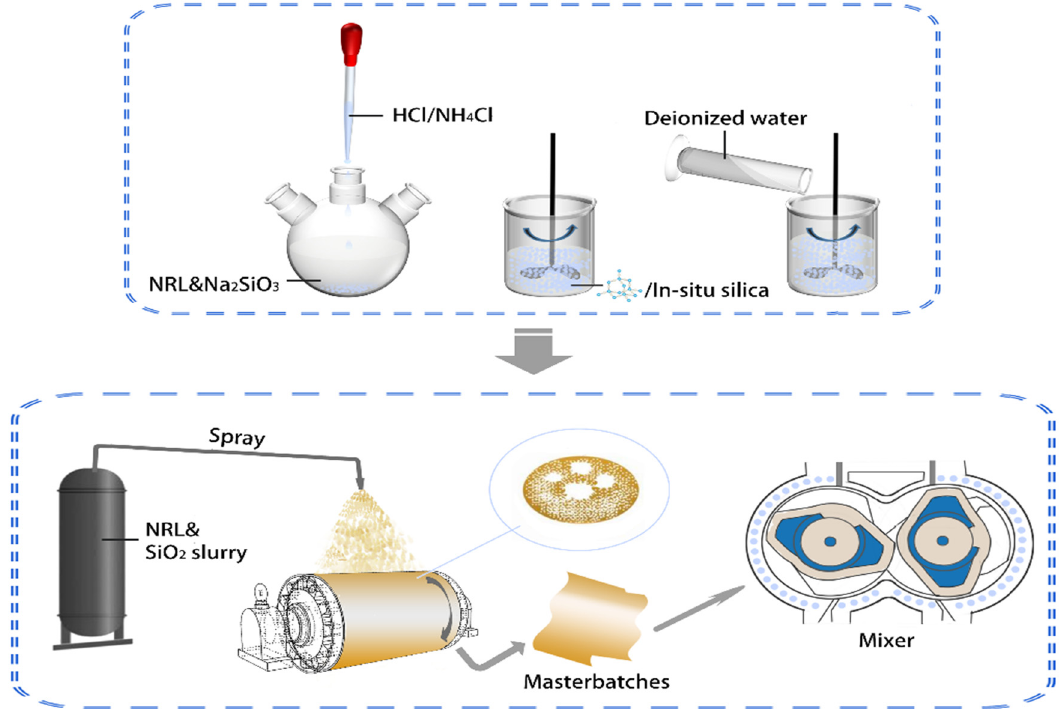
Figure 1: Schematic of preparation of silica/NR composite by spray sputtering combined with in situ